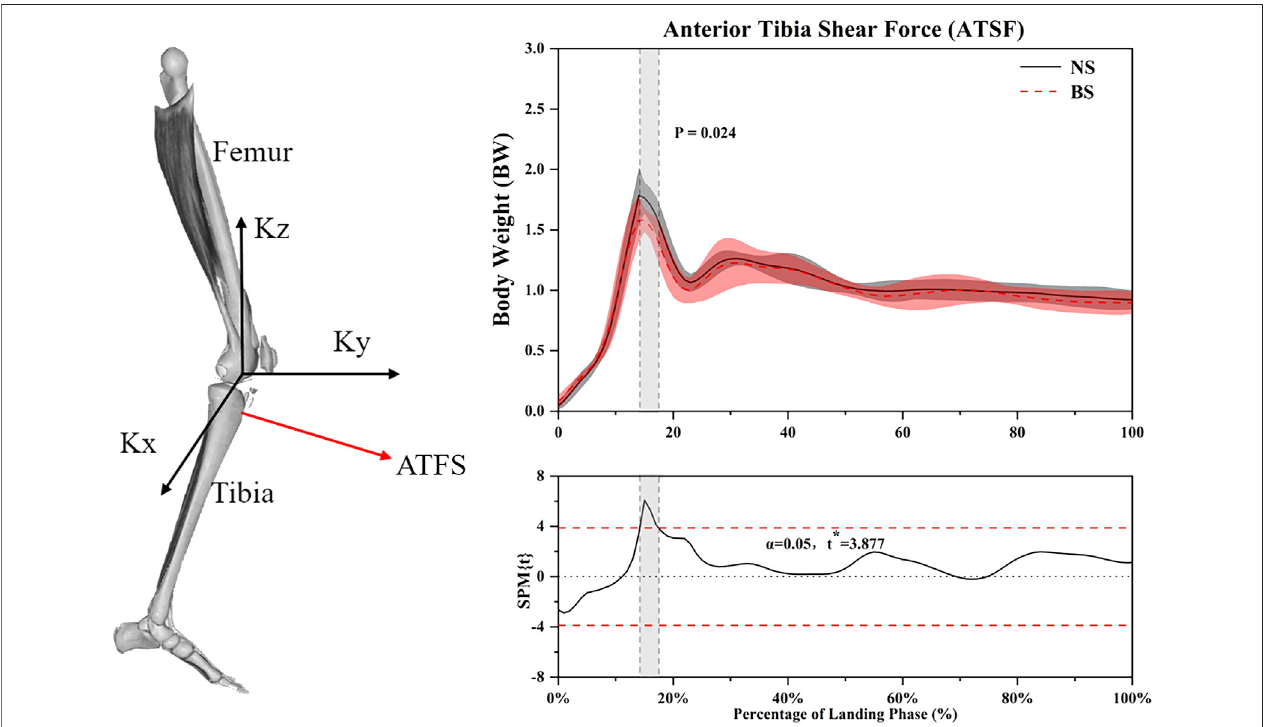
FIGURE5| TheStatisticalParametricMapping(SPM)resultsbetweenNSandBSduringsingle-leglandingtask,depictingthemeananteriortibiashearforce.Grey shaded areas indicate that there are signi fi cant differences ( p < 0.05) between NS and BS during the landing phase.